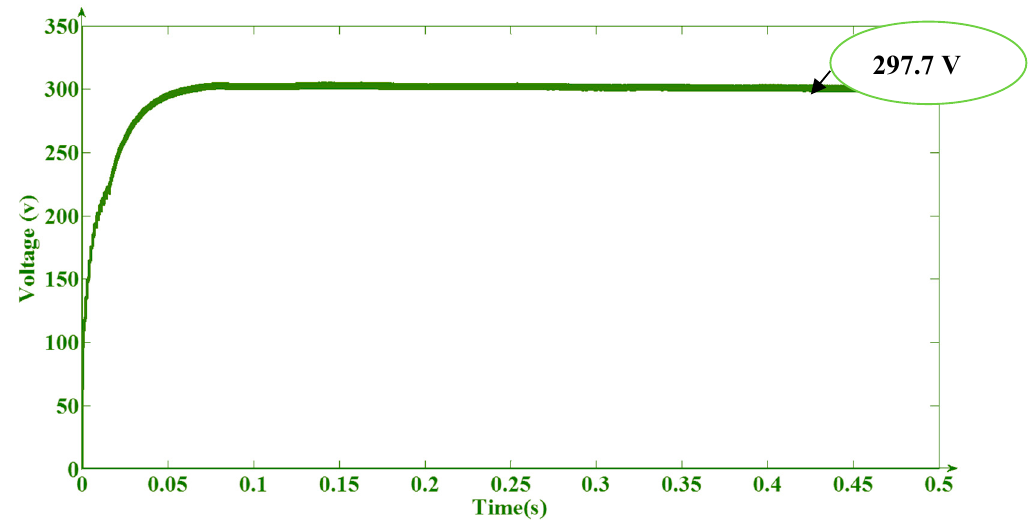
Figure 43. Voltage profile for proposed hybrid controller-1.